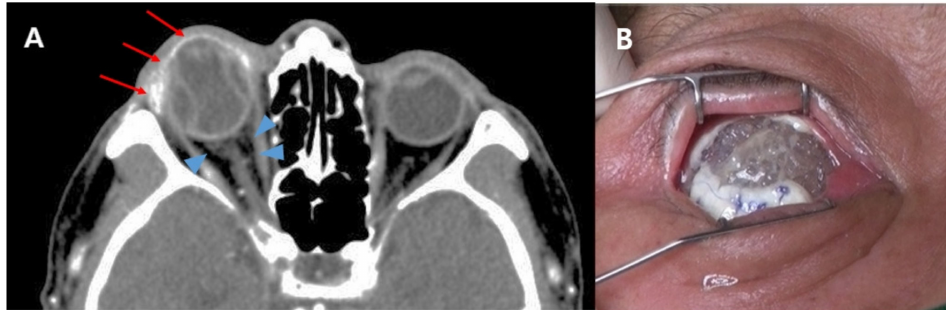
Figure 1. ( A ) Preoperative facial computed tomography (CT) image of a patient with implant extrusion. An axial postcontrast CT image shows enhancement on the anterior globe and lacrimal gland (arrows) and haziness in the retrobulbar area (arrowheads). Endophthalmitis with orbital cellulitis was diagnosed based on CT findings. ( B ) At 2 weeks follow-up after evisceration, the implant was exposed through a dehiscent wound and the implant was extruded on the next